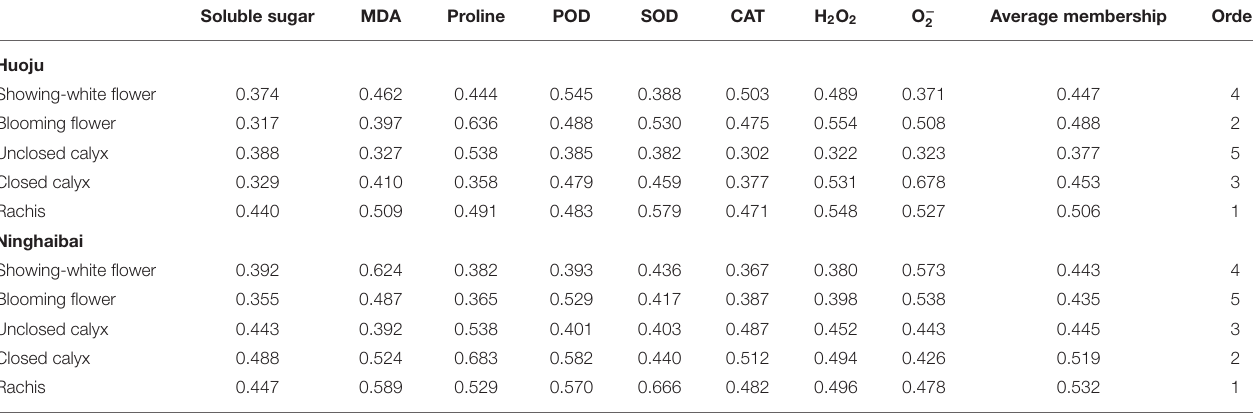
TABLE 1 | Membership degree of response to cold stress of different organs of “Huoju” and “Ninghaibai”.